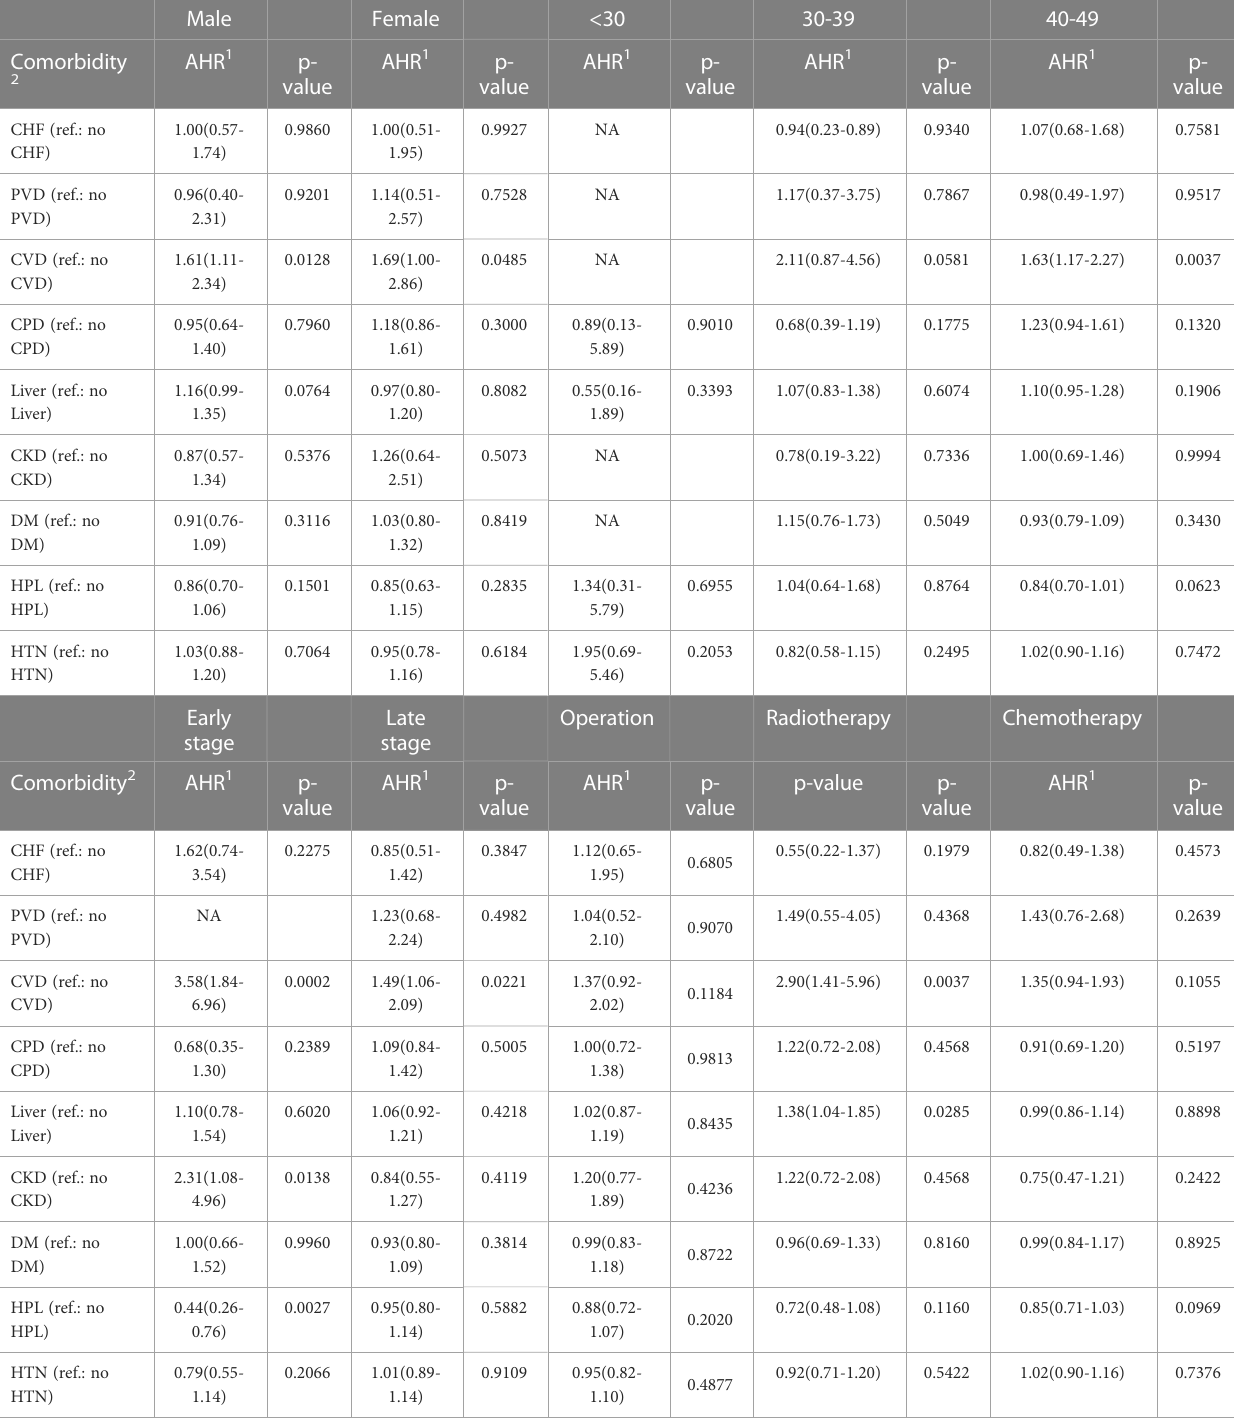
TABLE 3 The subgroup analysis of 5-year overall mortality risk among EO-CRC patients of different sex, age, clinical stages, and treatment